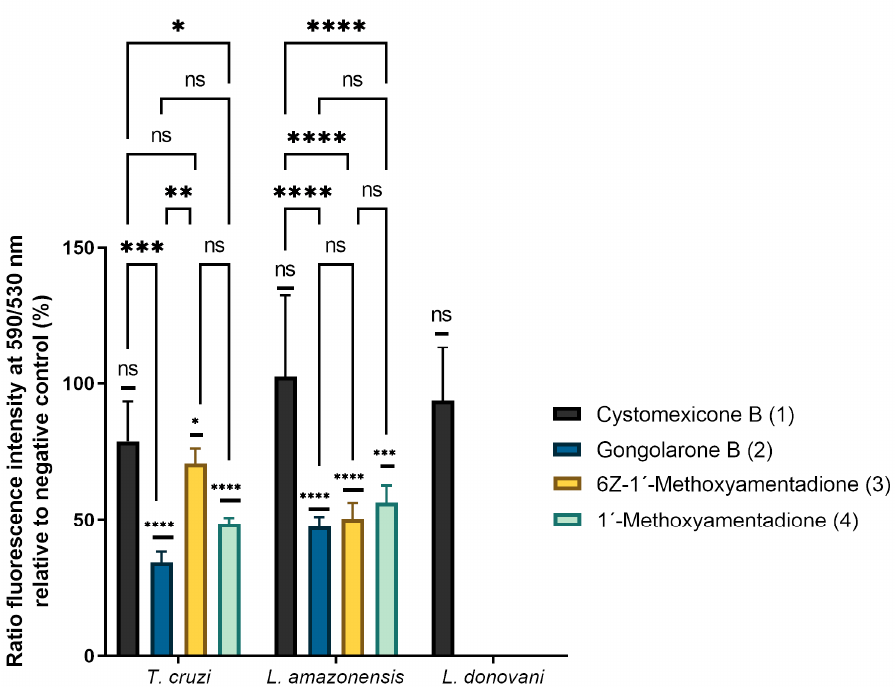
Figure 4. Percentages of ratio fluorescence intensity at 590/530 nm relative to negative control. The analysis of variance was determined by one-way ANOVA using GraphPad.PRISM ® 9.0 software. Significance differences when comparing different percentages values are represented like NS non- significant; * p < 0.1; ** p < 0.01; *** p < 0.001 and **** p < 0.0001.